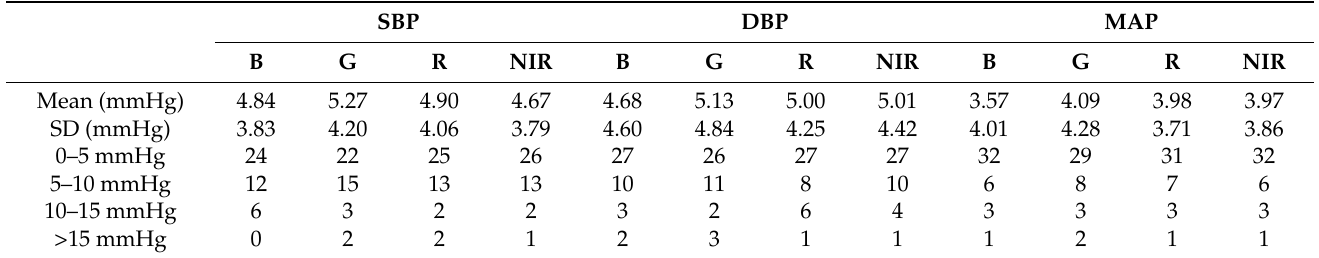
Table 4. Difference between estimated BP and measured BP with a cuff